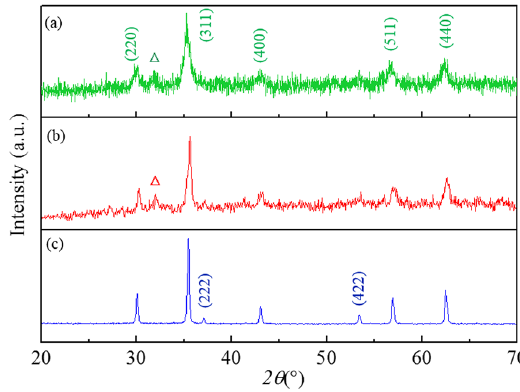
Figure 1. XRD patterns of specimens NZ-P (a), NZ-700 (b) and NZ-900 (c). The marked peak disappeared in (c). A special peak marked by “ Δ ” from specimen in (a) and (b) disappears in (c).